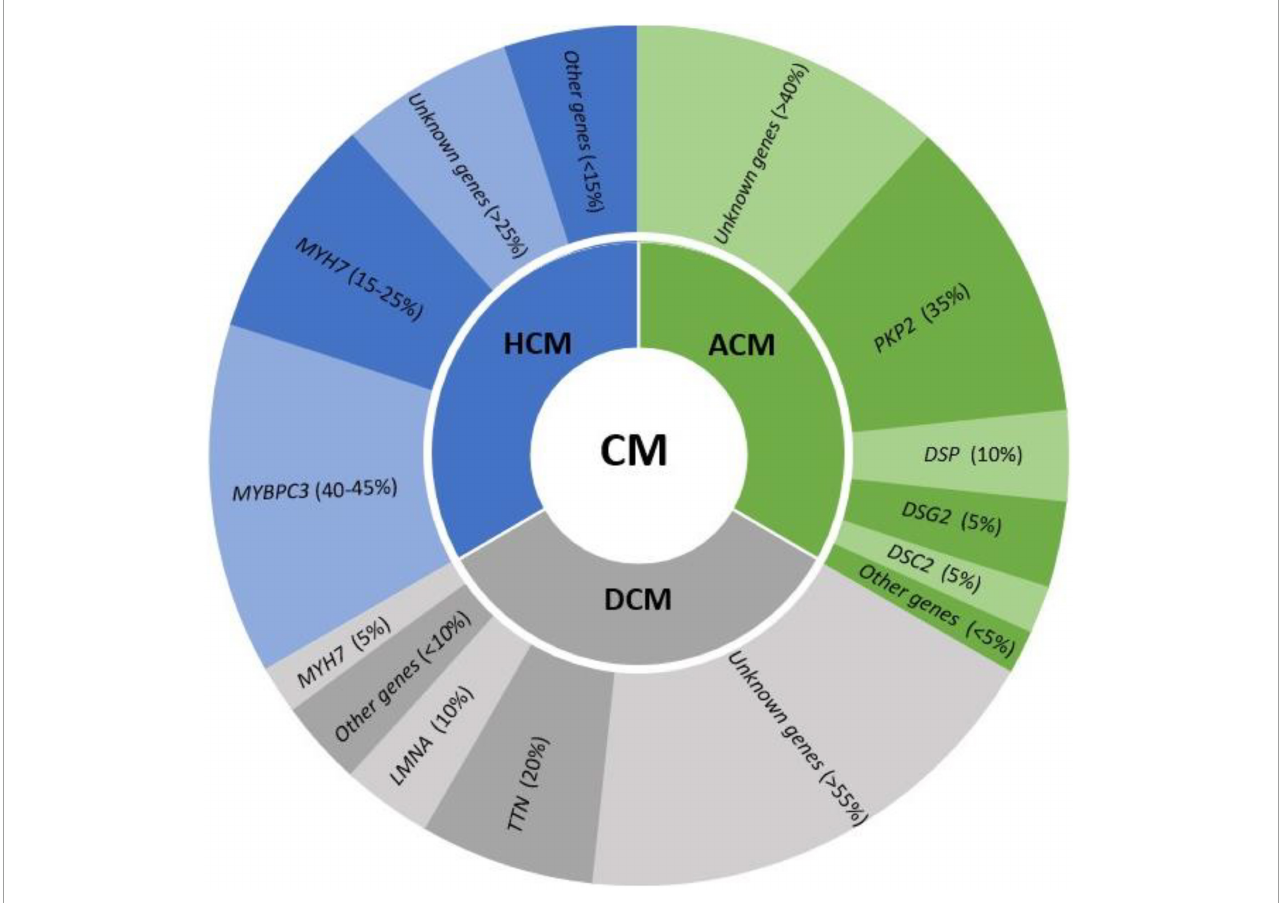
FIGURE2 Genes involved in the main cardiomyopathies (CM) and their frequency in each syndrome. HCM, hypertrophic cardiomyopathy; ACM, arrhythmogenic cardiomyopathy; DCM, dilated